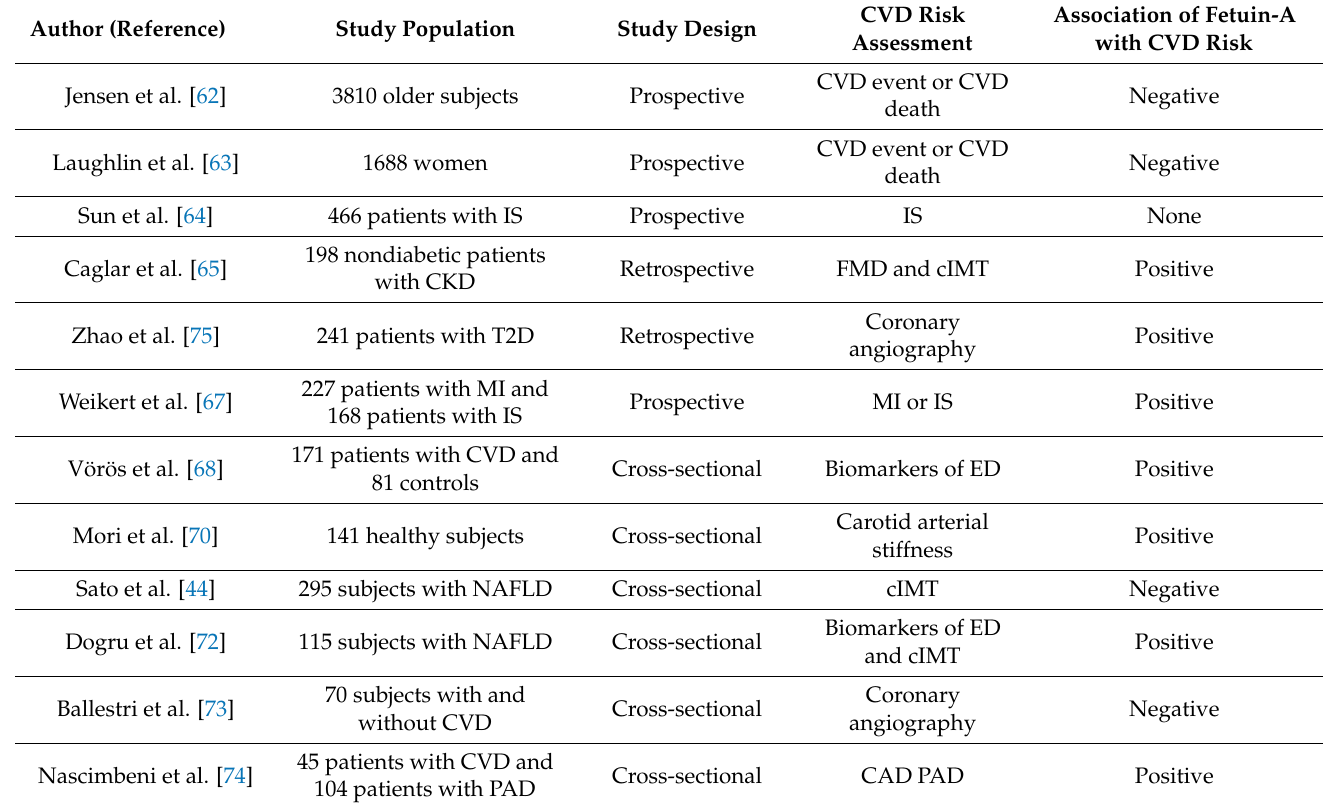
Table 2. Studies investigating the relationship of fetuin-A with CVD in subjects with and without